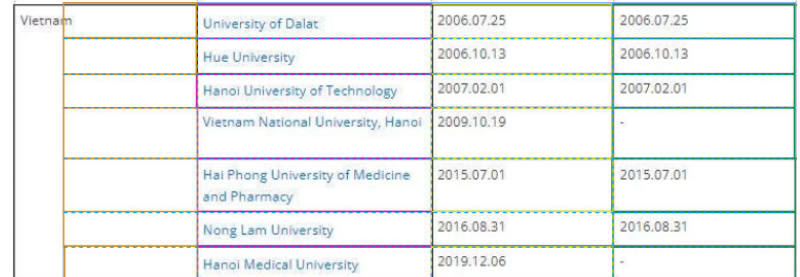
Figure 35. Result with wrong box locations (3).